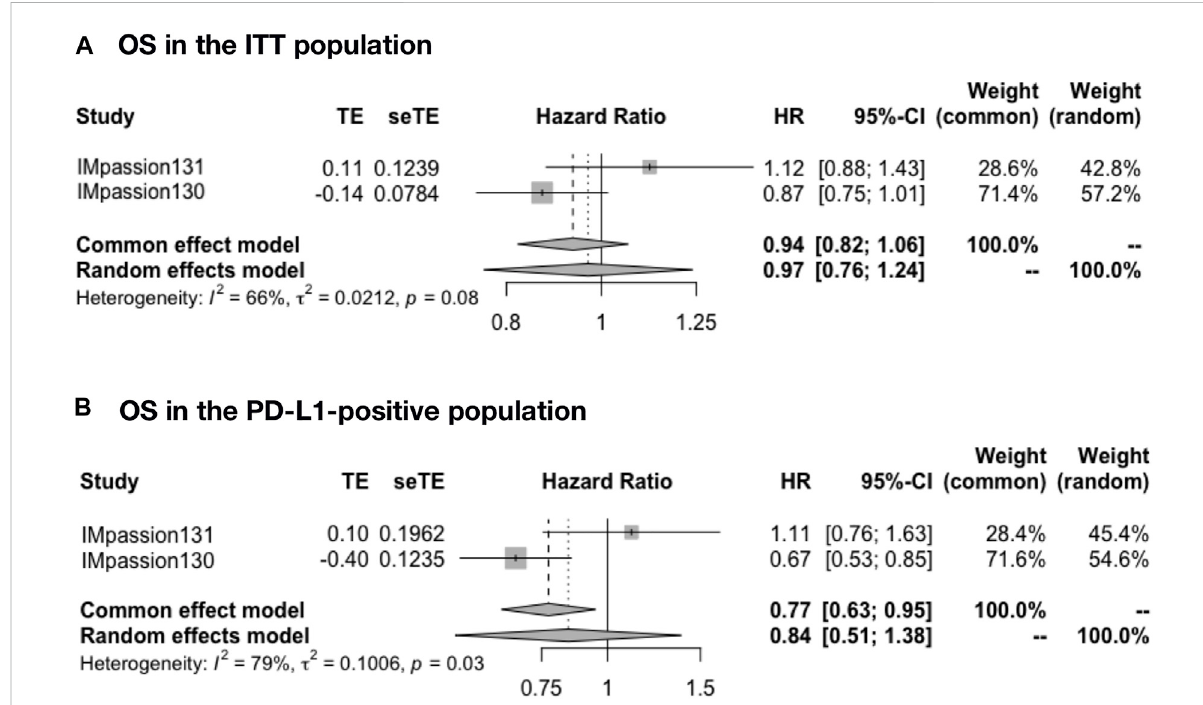
FIGURE 3 PooledOSinadjuvanttherapyclinicaltrials. (A) OSpooledresultsintheITTpopulationinthecomparisonofICIsplusCTversusplaceboplusCT. (B) OS pooled results in the PD-L1-positive population. OS, overall survival; ITT, intent-to-treat; HR, hazard ratio; 95% CI, 95% con fi dence interval; ICIs, immune checkpoint inhibitors; CT,